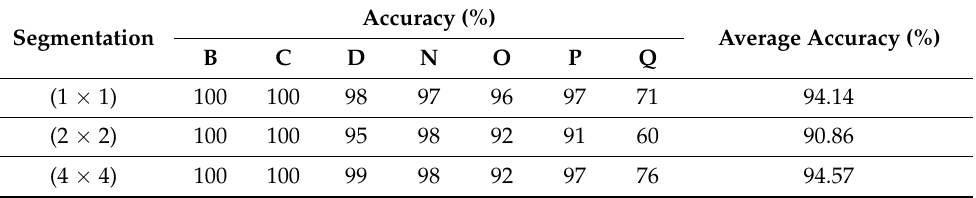
Table 7. Comparison of the results obtained using different divided blocks with changes in facial expression.